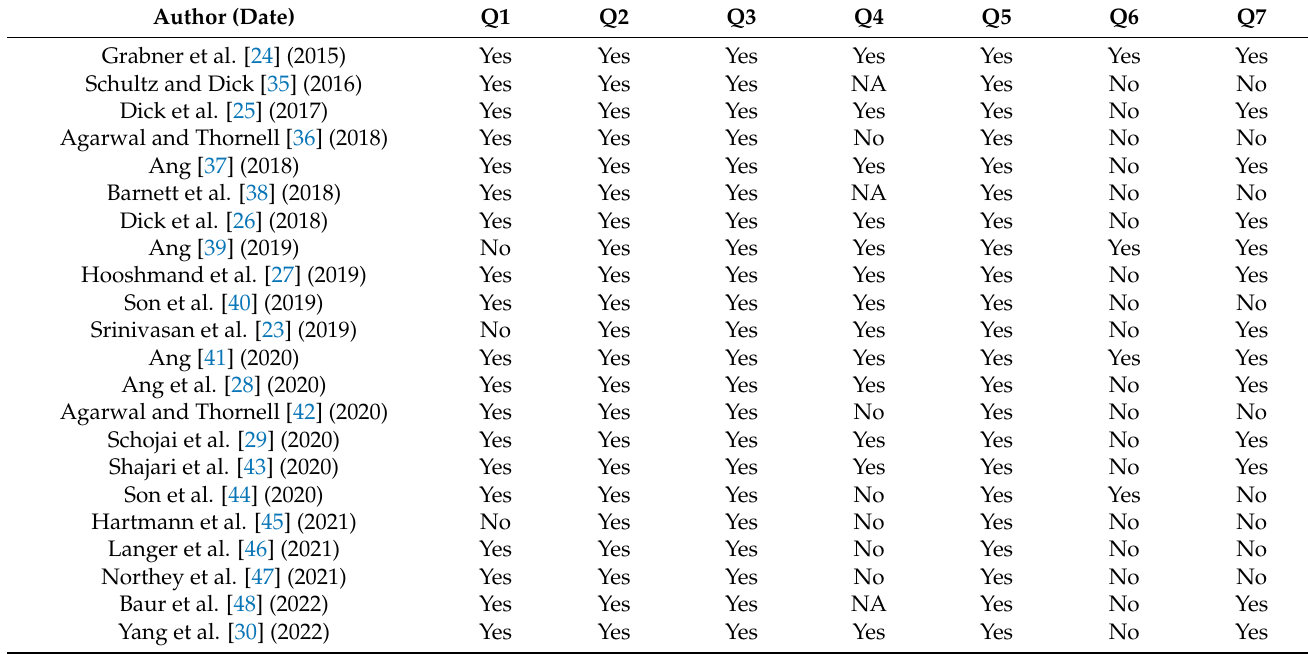
Table 1. Quality assessment of